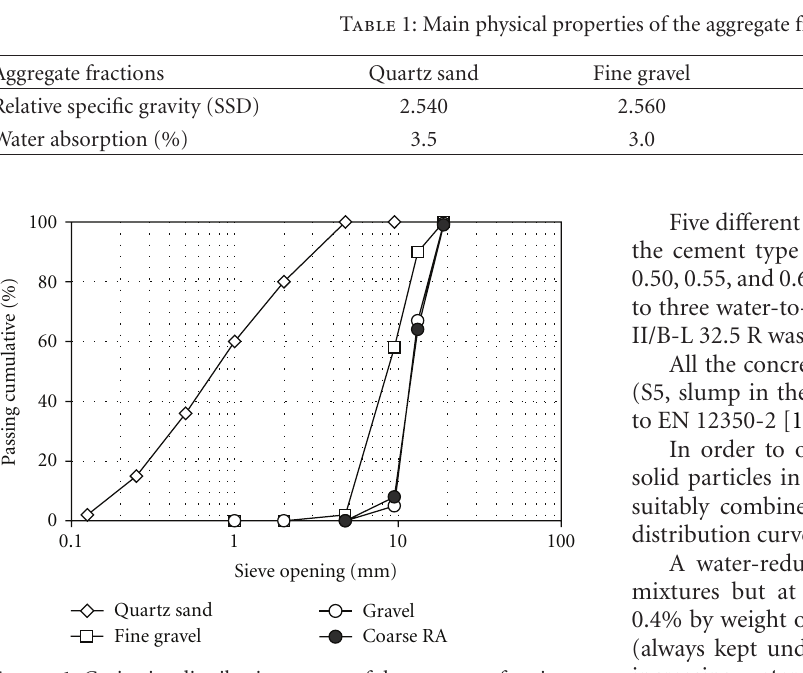
rubble from concrete structure demolition is suitably